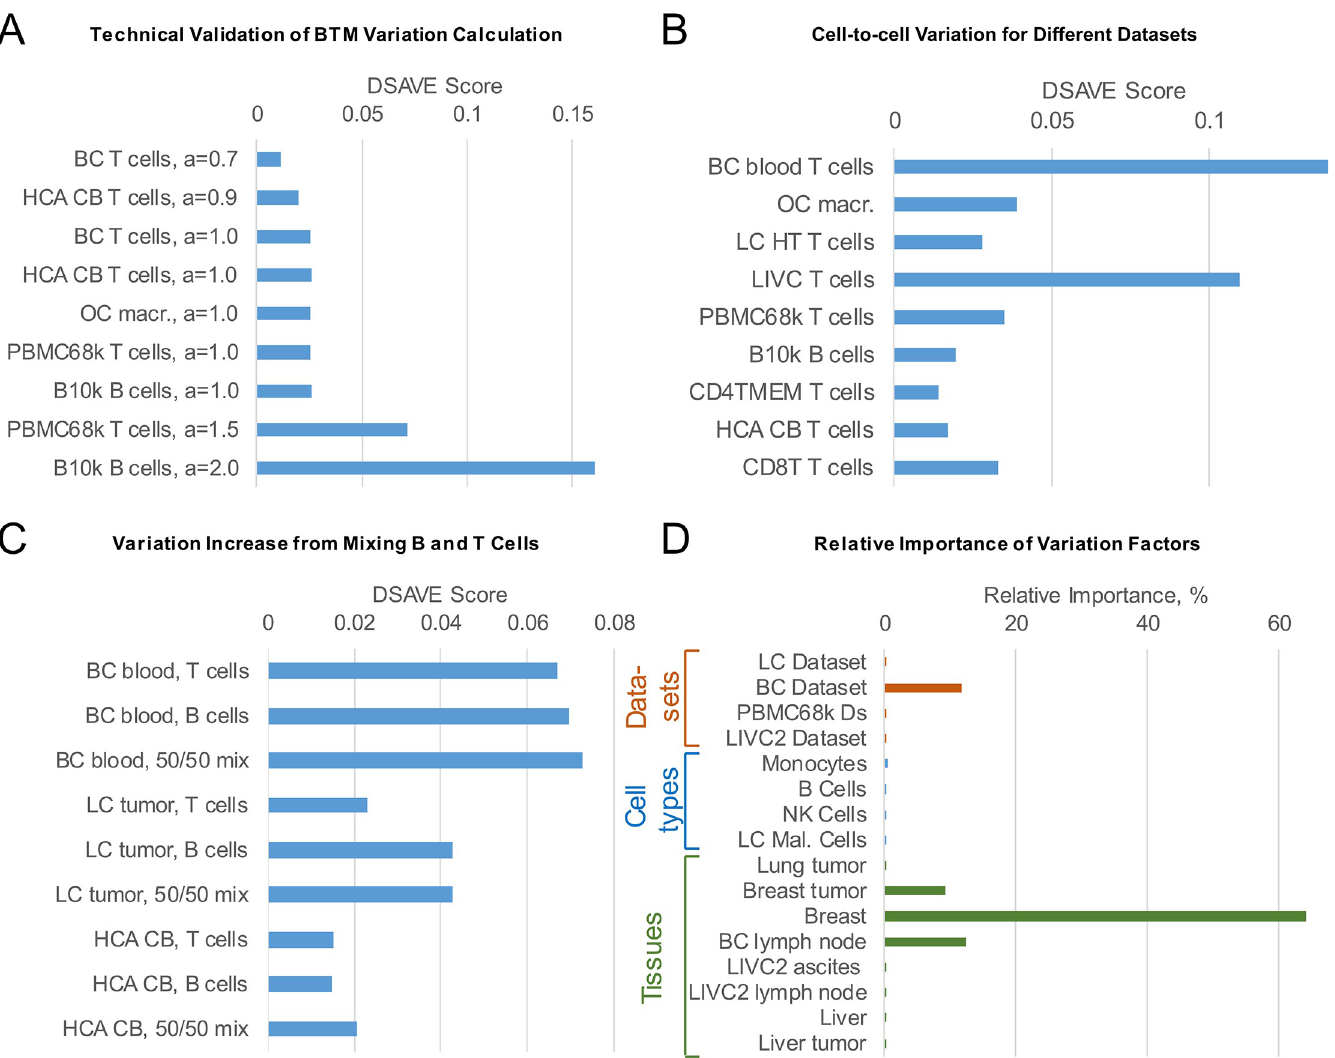
Fig 6. Evaluation of the DSAVE variation score. A. Technical validation of the DSAVE variation score. All cell populations were generated in a similar fashion as the SNO cell population, except the probabilities for each gene was multiplied by a noise factor f. The noise factor was calculated as f = 2N � a, where N is a standard normal distribution and a is a positive parameter that describes the magnitude of the noise. The probabilities are then normalized to a sum of 1. The figure shows an increasing score with increasing BTM variation, and demonstrates that the score is similar when the same noise level is applied, regardless of cell type or number of reads. B. BTM variation (DSAVE Score) for different datasets. C. Comparison between cell populations with 50% B cells and 50% T cells, and their pure counterparts, for a single patient. A specialized template with 1346 cells was used here due to small cell population sizes. D. Relative importance of variation factors calculated from 5 datasets. The graph shows which factors (dataset, cell type, and tissue of origin; indicated by red, blue, and green bars, respectively) can explain differences in the DSAVE variation score between cell populations.